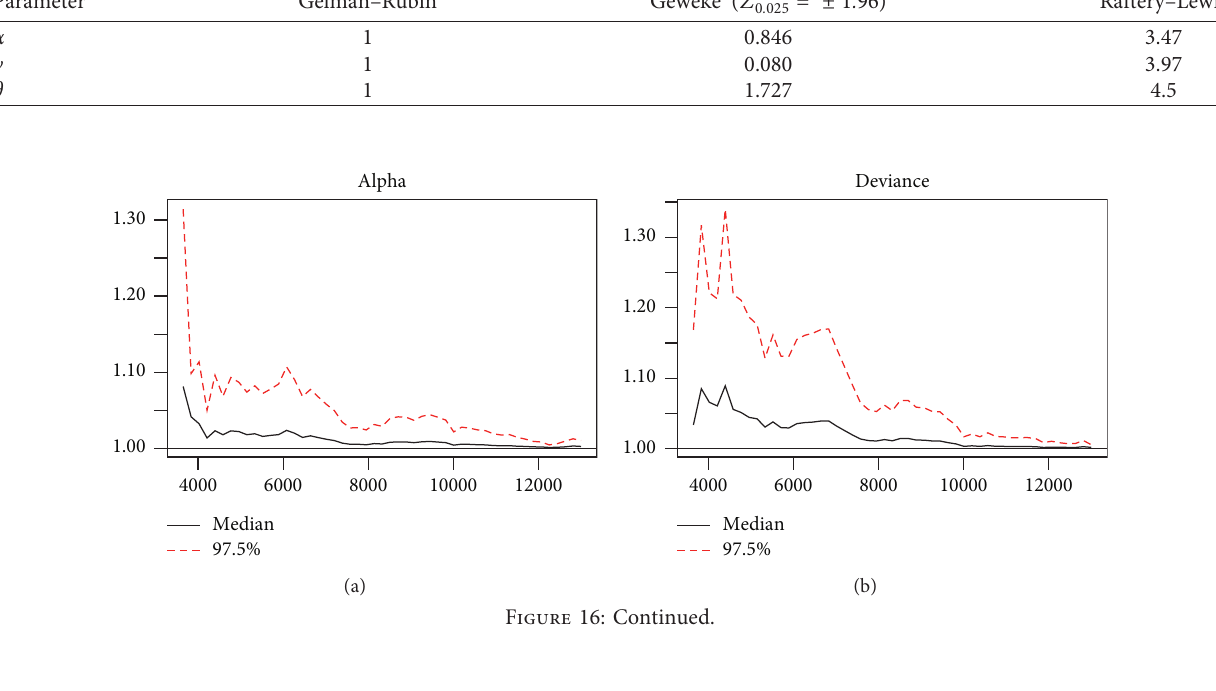
Figure 15: Histogram plots of each parameter of NGE-Weibull distribution. Table 10: Diagnostics by the Gelman–Rubin, Geweke, and Raftery–Lewis methods for the parameters α , c , and θ based on the failure time data.